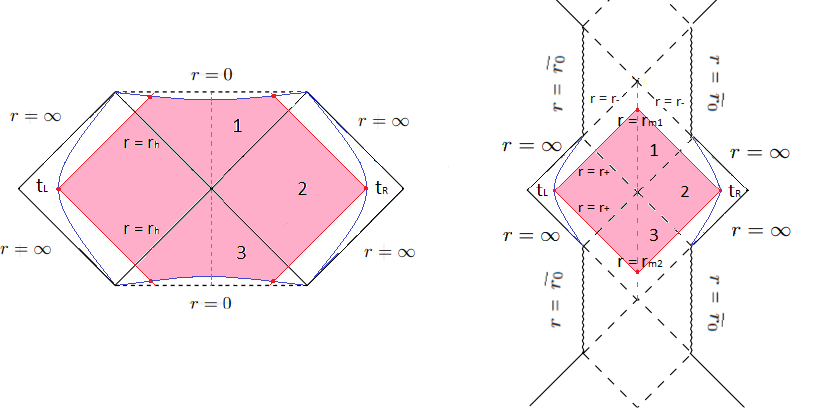
Figure 1 . Penrose diagram and WDW patch at t b = 0 for the non-rotating (left) and rotating (right) black